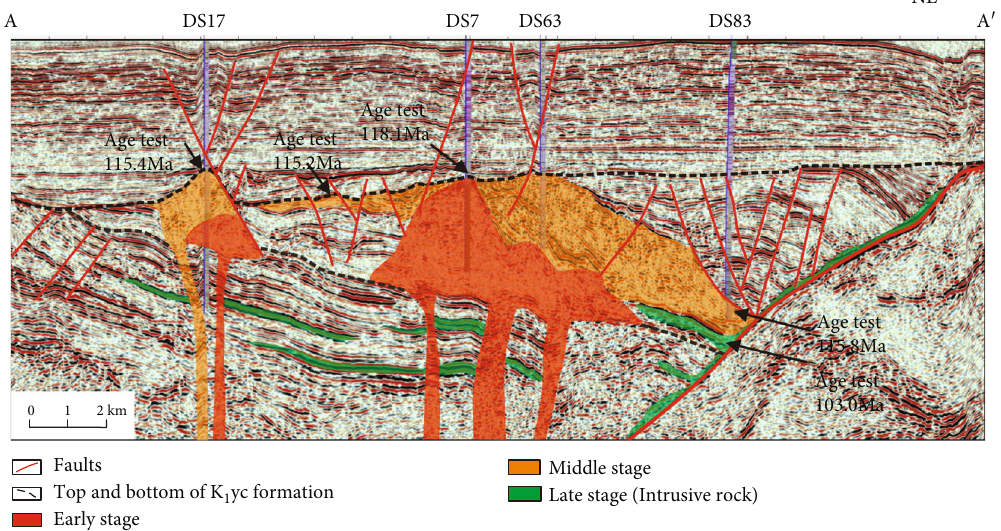
Figure 2: The seismic pro fi le shows the volcanic activity of the K (modi fi ed from